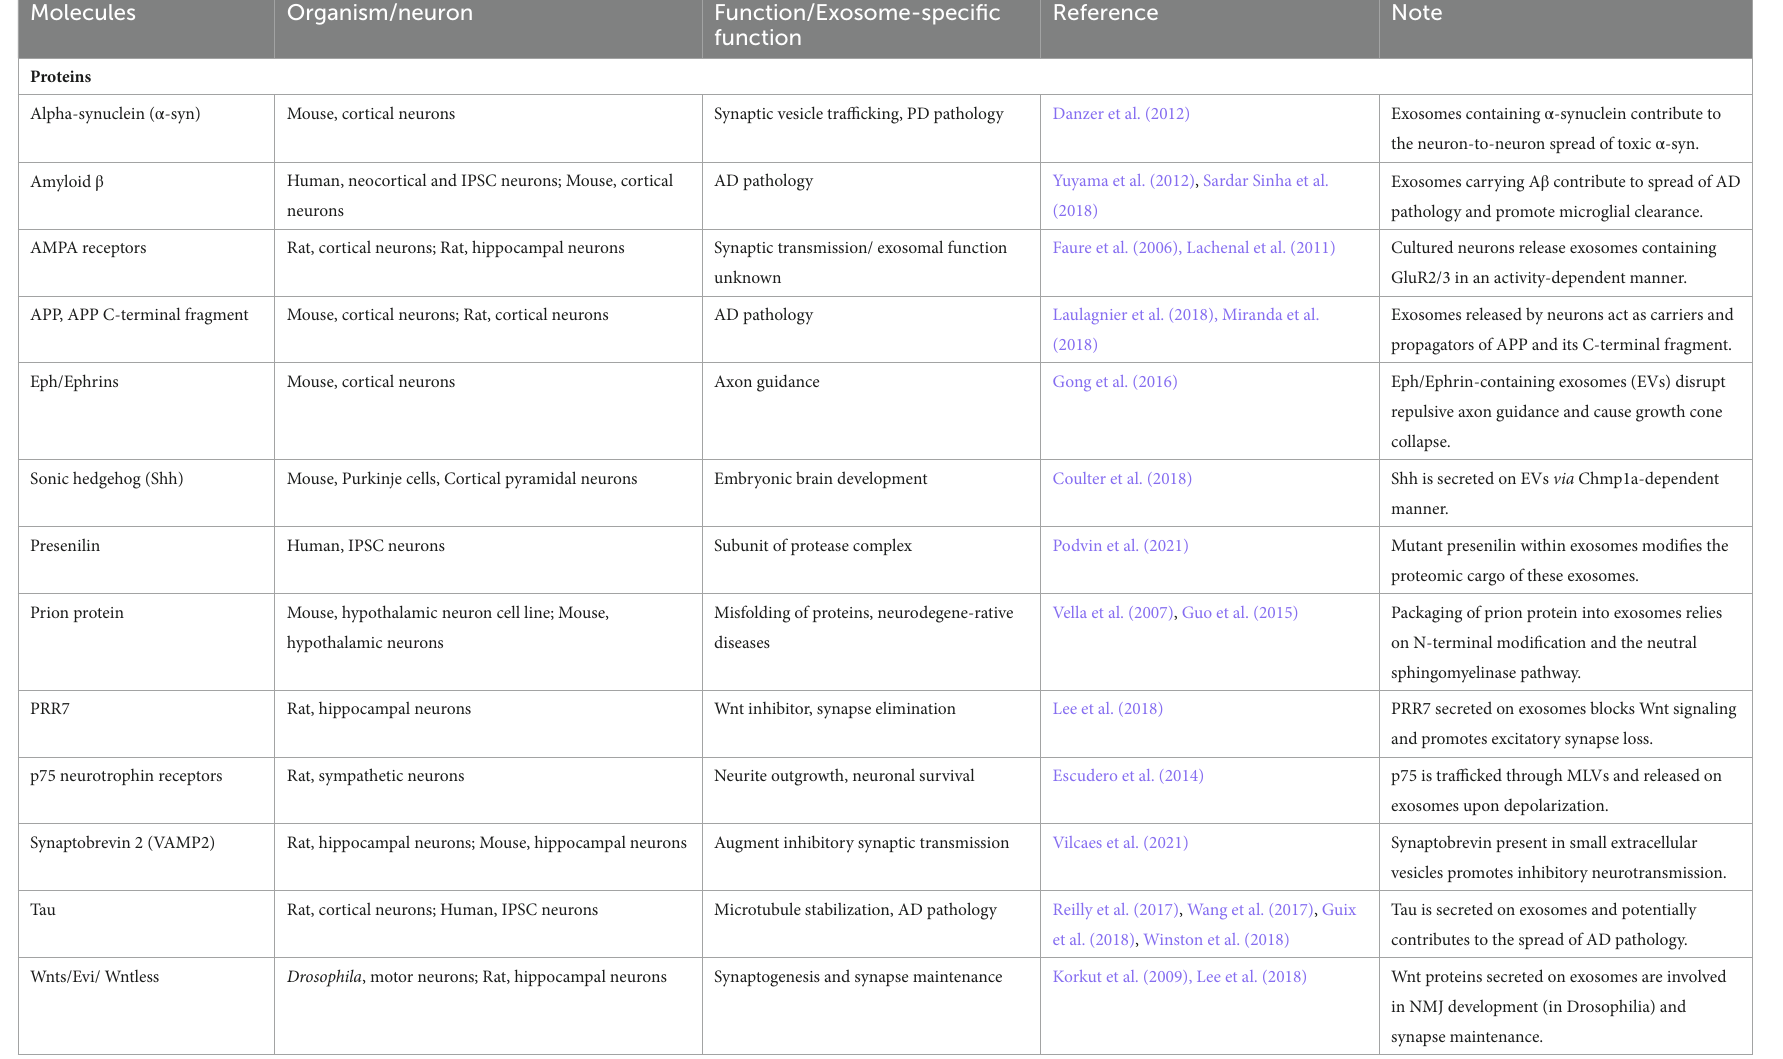
TABLE 1 Signaling and pathogenic molecules carried on neuronal